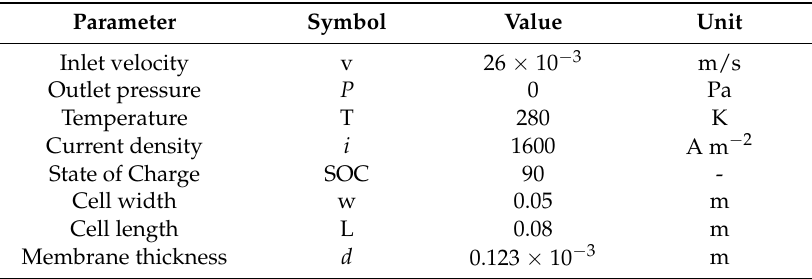
Table 4. General operating parameters.